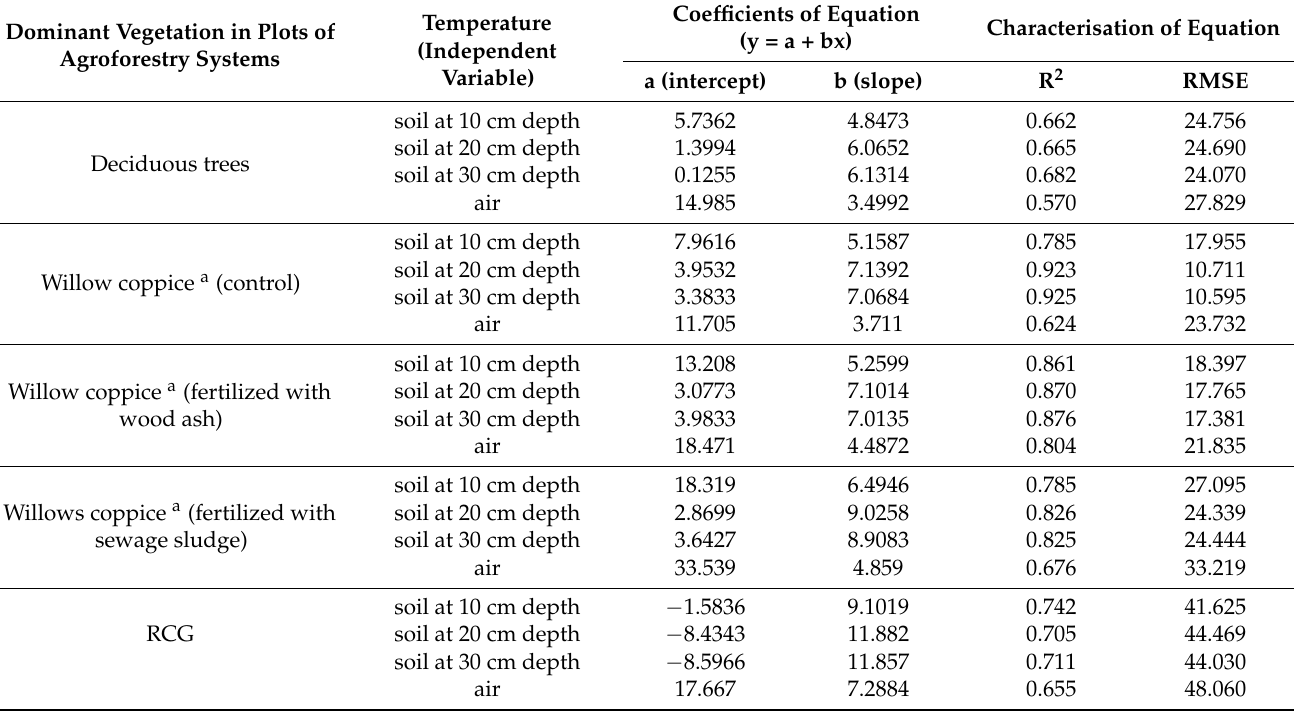
Table 4. Equations (linear regression) describe relationships between soil CO 2